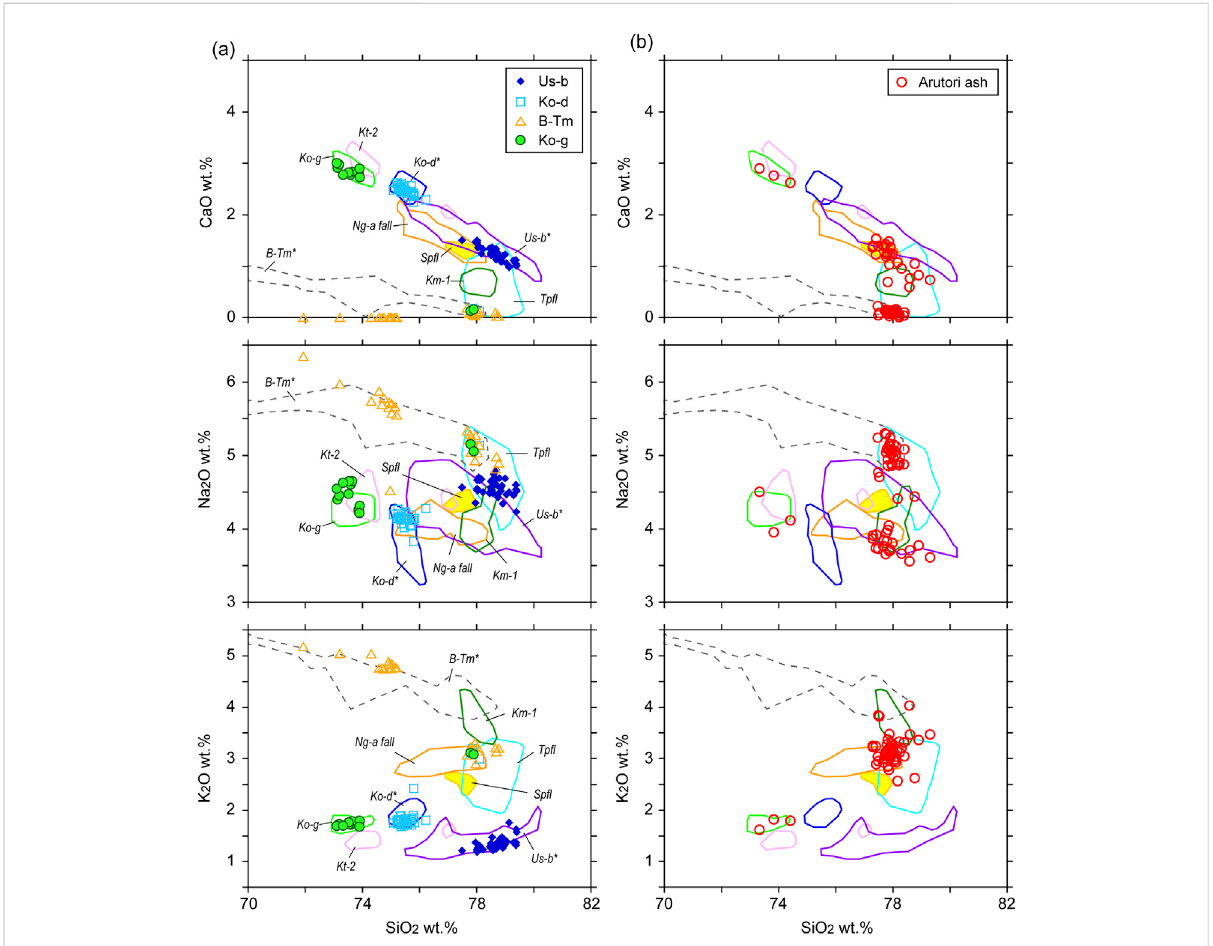
FIGURE 8 Selected SiO 2 variation diagrams for glass shard compositions of tephra layers including the Arutori ash. Compositional fi elds of each marker tephra derived from Figure 3. (A) Four tephra layers, Us-b, Ko-d, B-Tm, and Ko-g form distinct clusters while some glass shards of B-Tm and Ko-g overlap with the fi eld of the Tp fl deposit. Thus, the B-Tm and Ko-g tephras at this outcrop were contaminated with small amounts of Tp fl shards. (B) Chemical compositions of glass shards of the Arutori ash form three groups that fall within the fi elds of the Tp fl ash, Ng-a, and Kt-2 (or Ko-g) with Tp fl shards being the most dominant type. Glass shards plotting in the Ko-g fi eld probably correlate to older tephras of Hokkaido-Komagatake volcano, such as